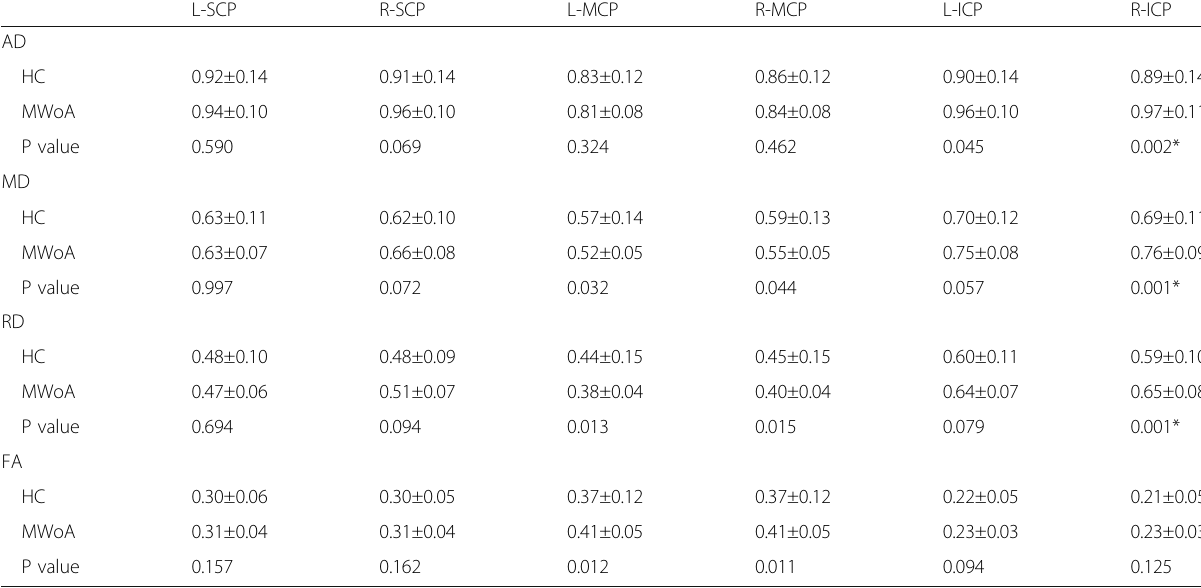
Table 3 Diffusion characteristics for 3 major cerebellar tracts in the MWoA and healthy